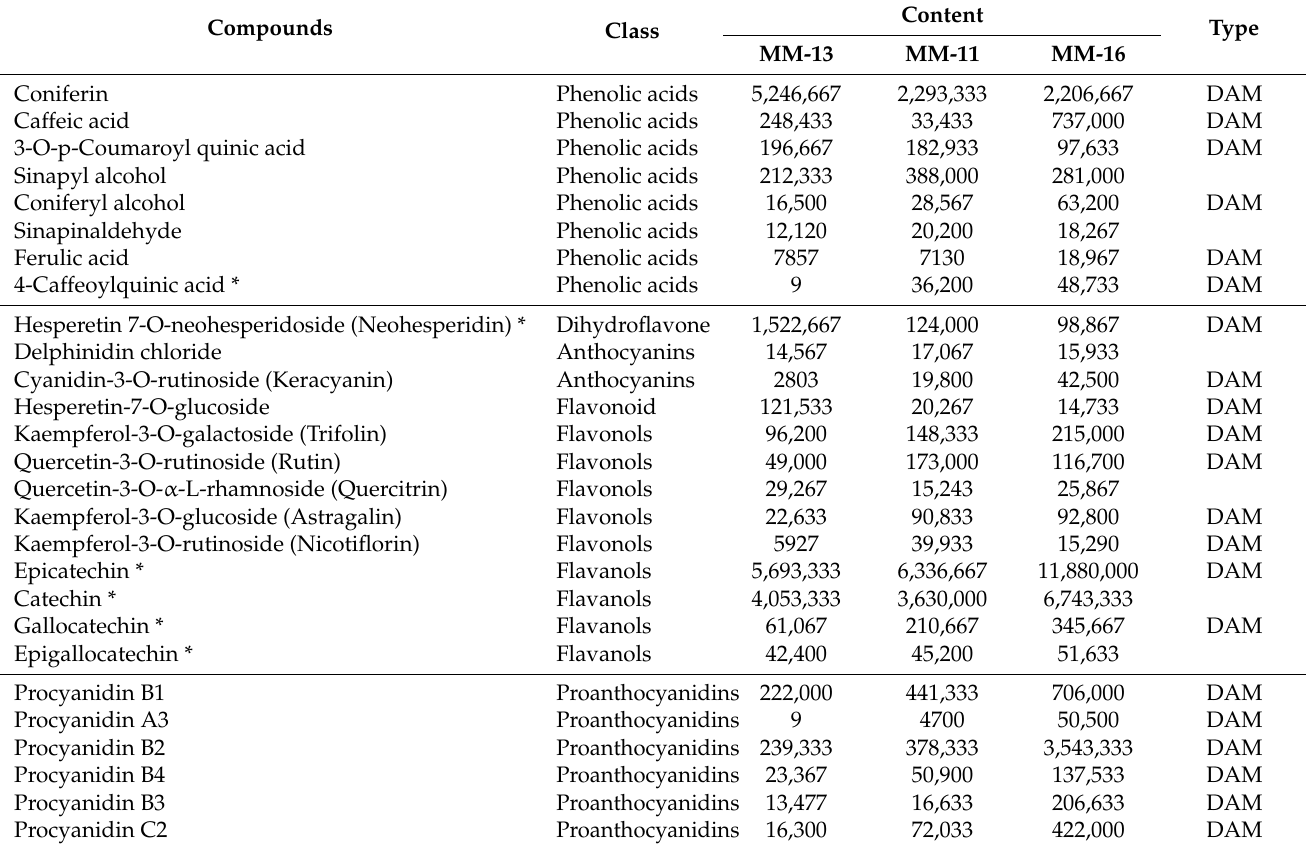
Table 2. Detected metabolites involved in phenylpropanoid, flavonoid and anthocyanins